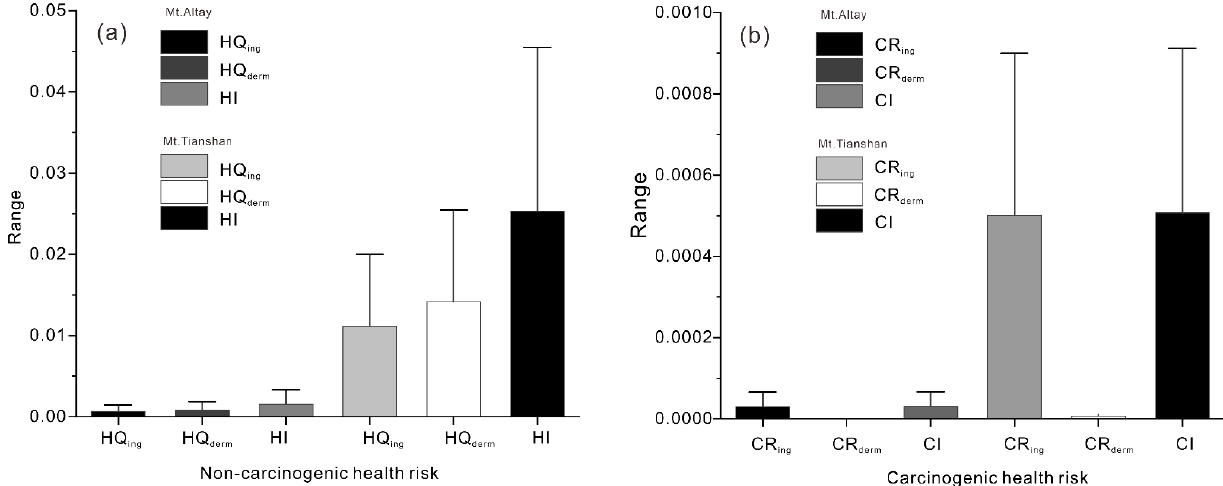
Figure 7. The non-carcinogenic ( a ) and carcinogenic ( b ) health risks for waters in the regions of the Tianshan and Altay Mts.